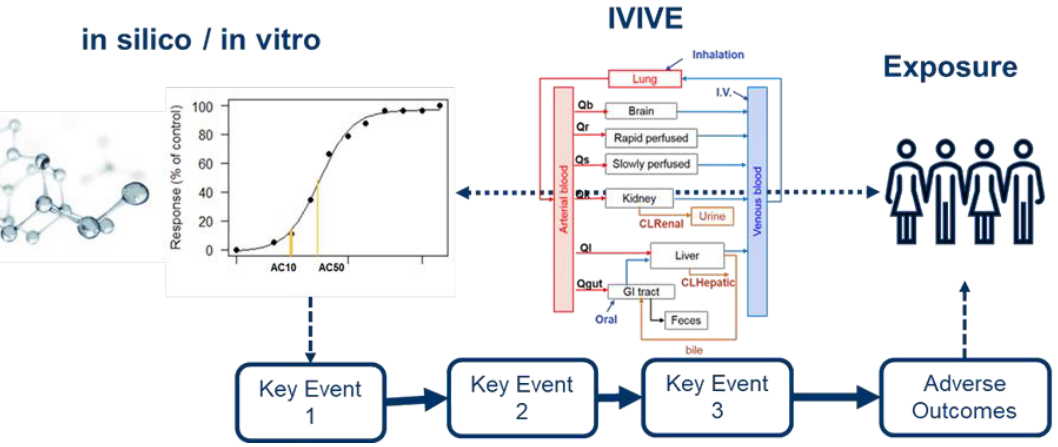
Figure 1. Schematic representation of NAM-based testing approach in risk assessment. Diverse ev- idence provided by NAMs (e.g., AOPs, IVIVE, and in vitro and in silico technologies) enables the integration of human exposure to kinetic and dynamics information needed for risk assessment without using in vivo animal data (Part of NAM-00 presentation, Supplementary Materials).